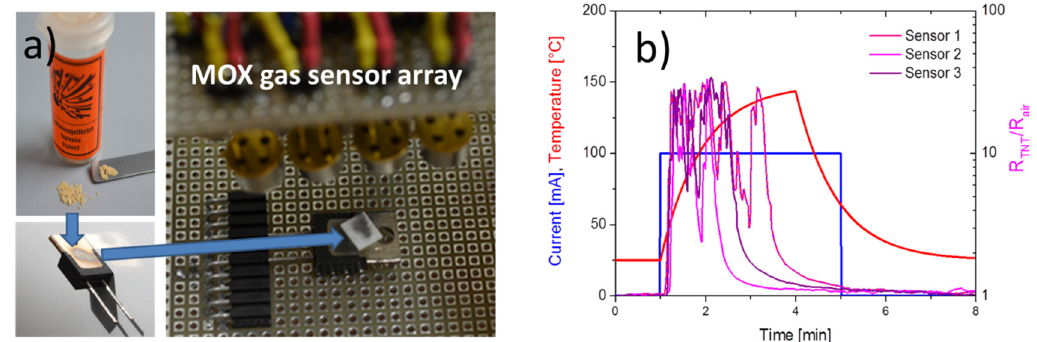
Figure 9. ( a ) Evaporation of TNT particles from an electrical heater into a MOX gas sensor array; ( b ) response of the sensors to the evaporating TNT particles (blue: current input into the heater element; red: resulting temperature ramp; colored curves: relative resistance response of the sensors to the resulting TNT vapor pulses.